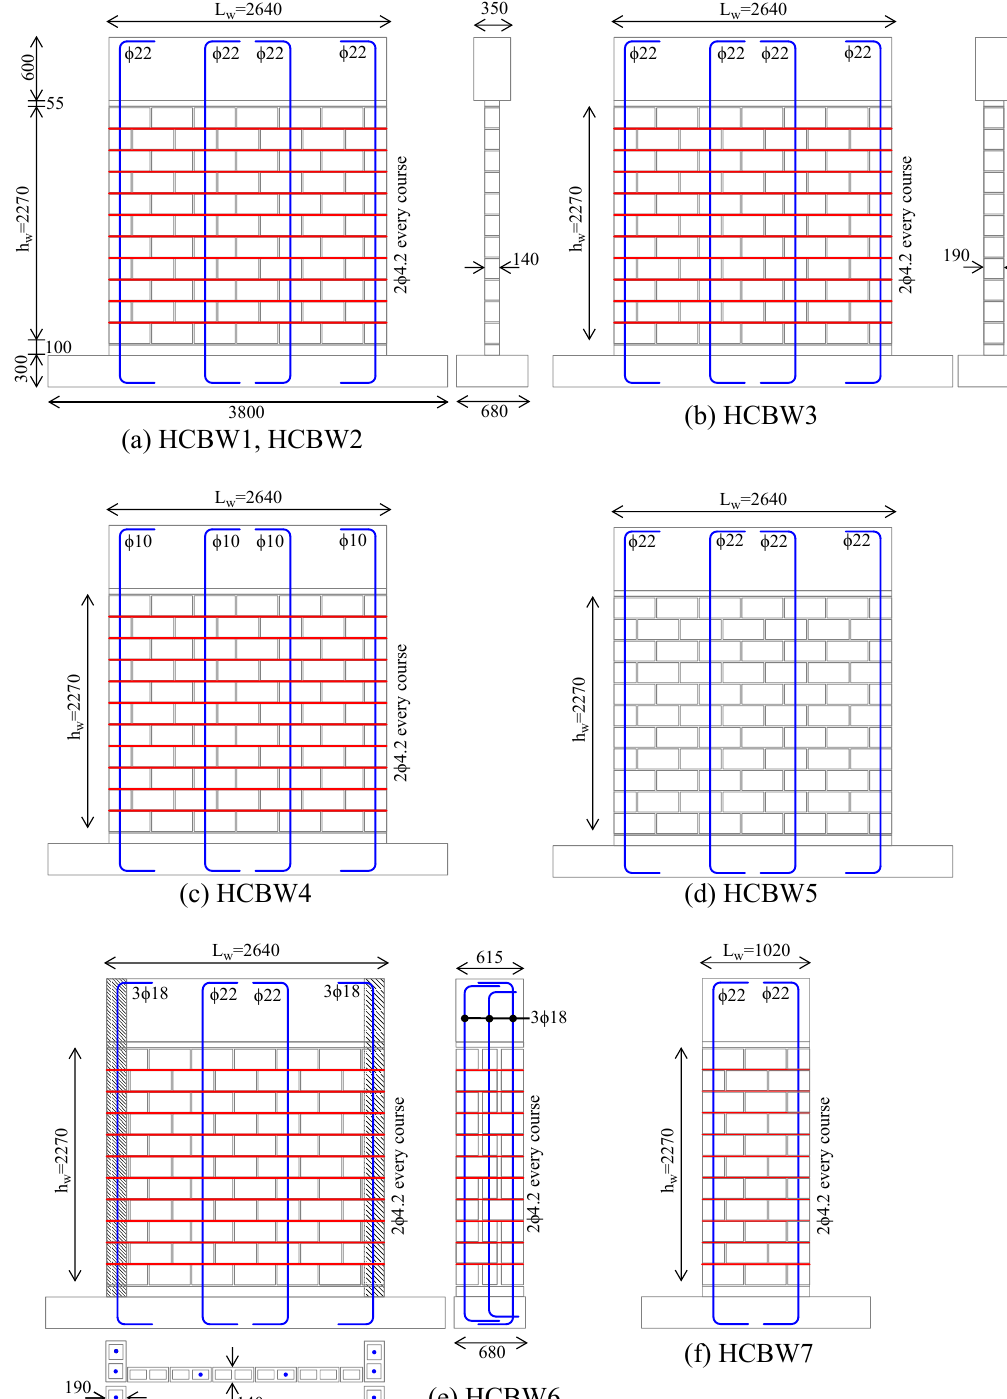
Figure 1. Tested BJ-PG-RM wall schemas: ( a ) walls HCBW1 and HCBW2, ( b ) wall HCBW3, ( c ) wall HCBW4, ( d ) wall HCBW5, ( e ) wall HCBW6, and ( f ) wall HCBW7. Dimensions in